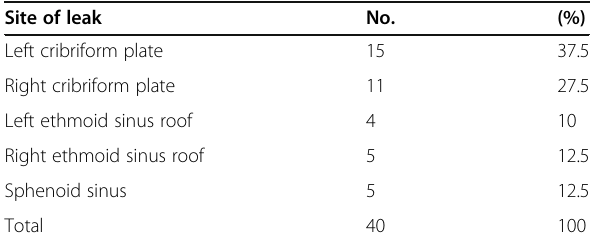
Table 4 Site of CSF leak